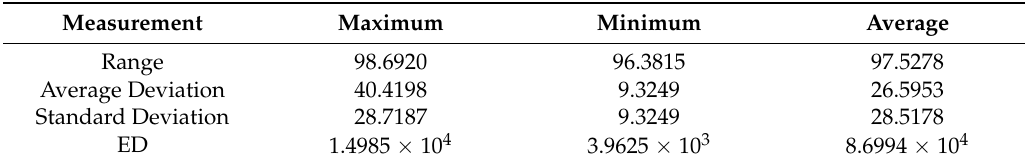
Table 2. Comparison of several discrete degree metrics.